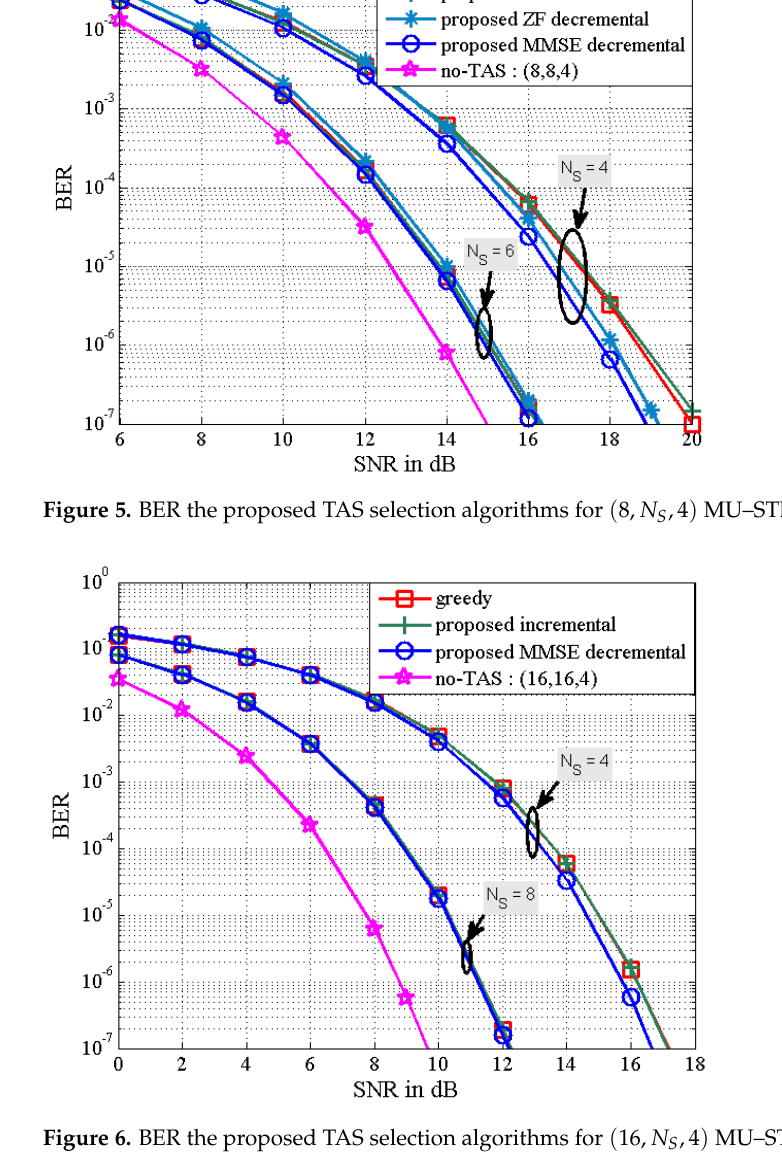
Figure 6. BER the proposed TAS selection algorithms for (16, ,4) S N MU–STLC system.